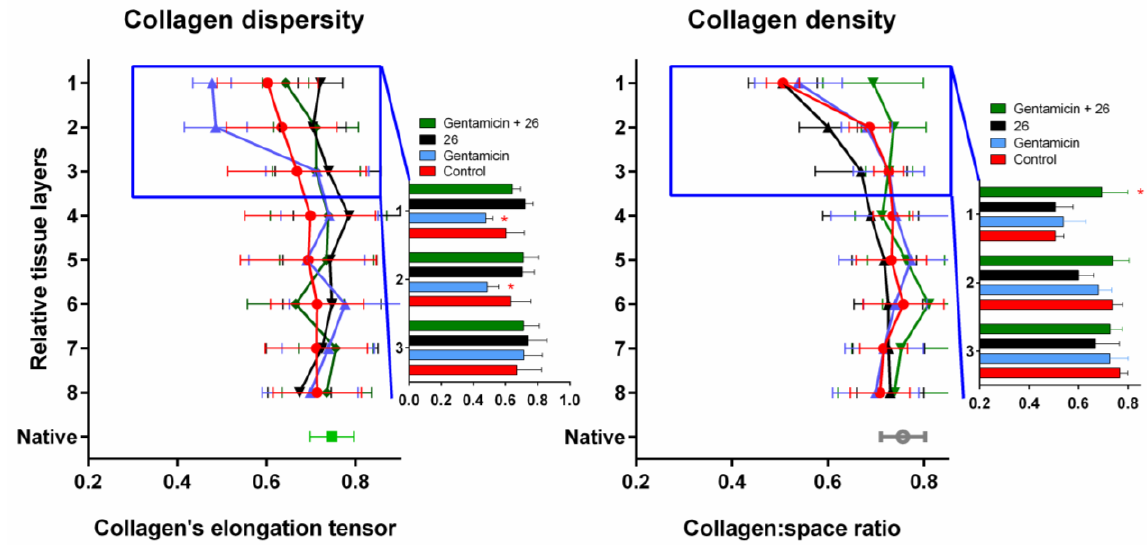
Figure 9. The collagen dispersity and collagen density in rat skin areas subjected to infection and treated for 15 days with 26 combined with gentamicin, solely gentamicin, solely 26 , or vehicle gel as indicated. Parameters corresponding to tissue unaffected in surgery are marked as Native. Relative tissue layers correspond to horizontal layers of the grid used for images analysis where the first layer corresponds to the top of the recovered tissue. Mean ± SD from five calculations is shown. Asterisks show significant difference with wounds treated with vehicle gel.